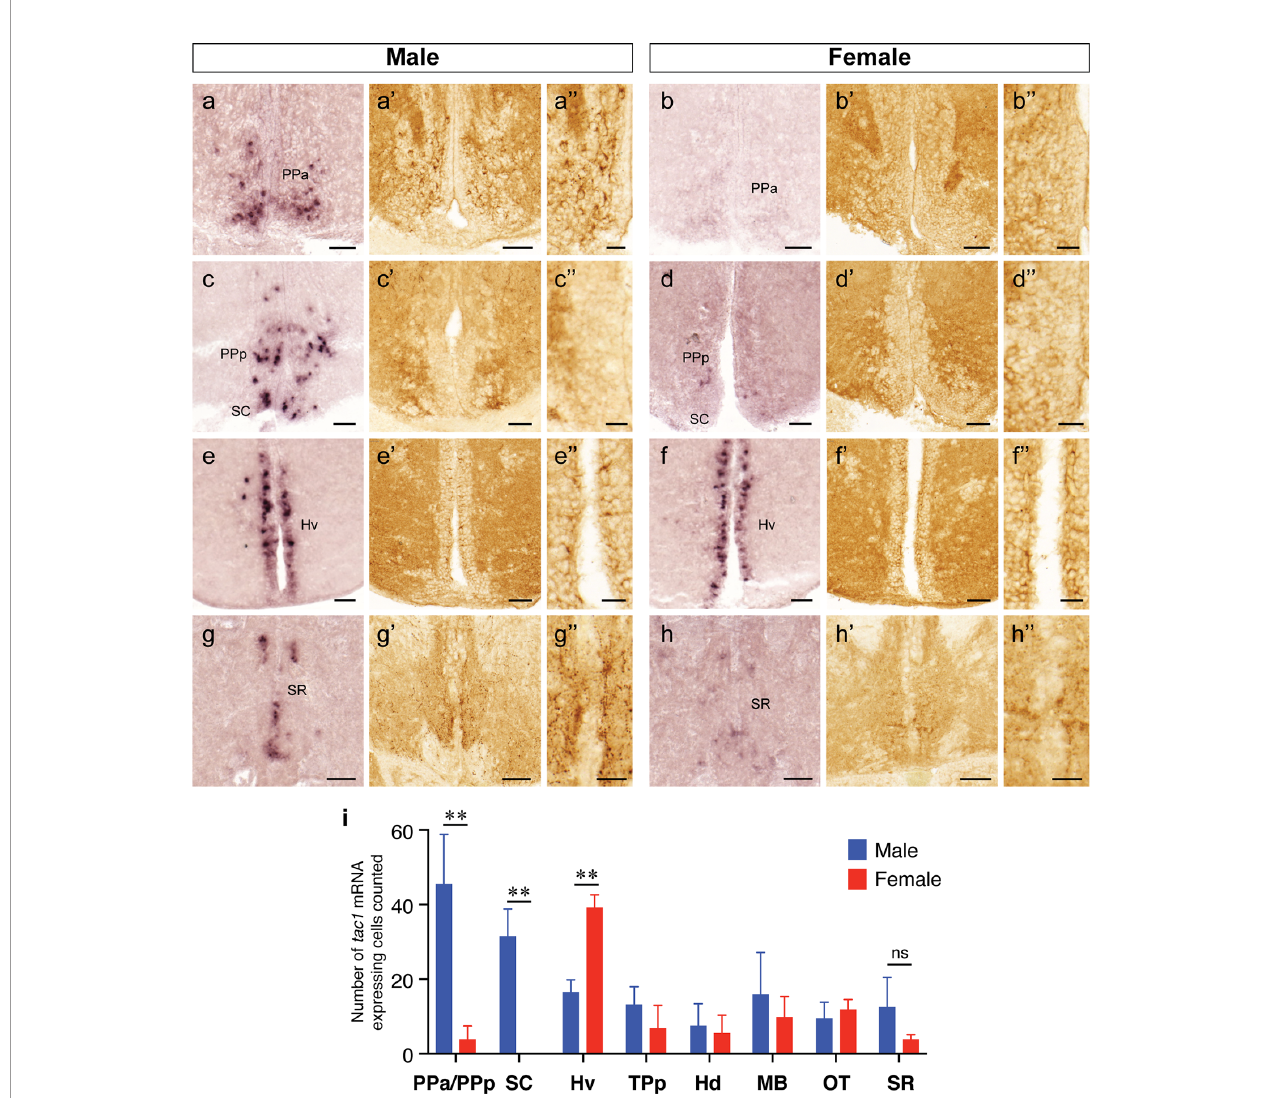
FIGURE 4 | Sexually dimorphic expression of tac1 mRNA and Tac1 immunoreactivity in the brain. Photomicrographs in the left (A − H) , middle (A ’ − H ’ ) and the right (A ” − H ” ) columns for each gender are tac1 mRNA, Tac1-immunoreactivity and a higher magni fi cation of respective Tac1 immunoreactivities observed in the middle panels, respectively. Bar graphs in the bottom panel (I) represent the number of cells expressing tac1 counted in different brain regions of males (blue columns) and female (red columns) fi sh. In the anterior part of the parvocellular preoptic nucleus (PPa), there were male-dominant tac1 mRNA expression (A and B) and Tac1 immunoreactivity (A ’ and B ’ ) . In the posterior part of the parvocellular preoptic nucleus (PPp) and suprachiasmatic nucleus (SC), tac1 mRNA expression was signi fi cantly higher in males (C and D) , while no apparent sexual dimorphism was observed in Tac1 immunoreactivity (C ’ and D ’ ) . In the ventral region of the periventricular hypothalamus (Hv), numbers of cells expressing tac1 mRNA were higher in females as compared to males ( E, F, and I , P<0.01), while there was no apparent sexual morphism in Tac1 immunoreactivity (E ’ and F ’ ) . In the superior raphe, more number of cells expressing tac1 mRNA were observed in males (G and G ’ ) as compared to females (H and H ’ ) , but there was no signi fi cant difference (ns, I) . Scale bars: A − H and A ’ − H ’ : 50 µm; A ” − H ” : 20 µm. **P<0.01. See Glossary for